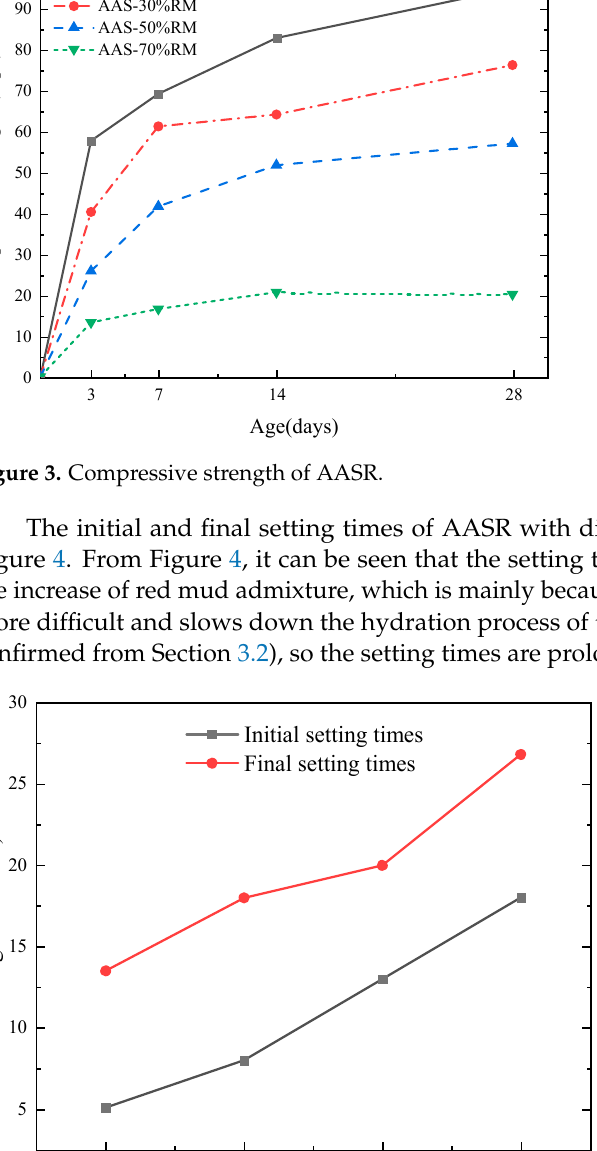
Figure 4. Effect of different red mud additions on the setting time of AASR.